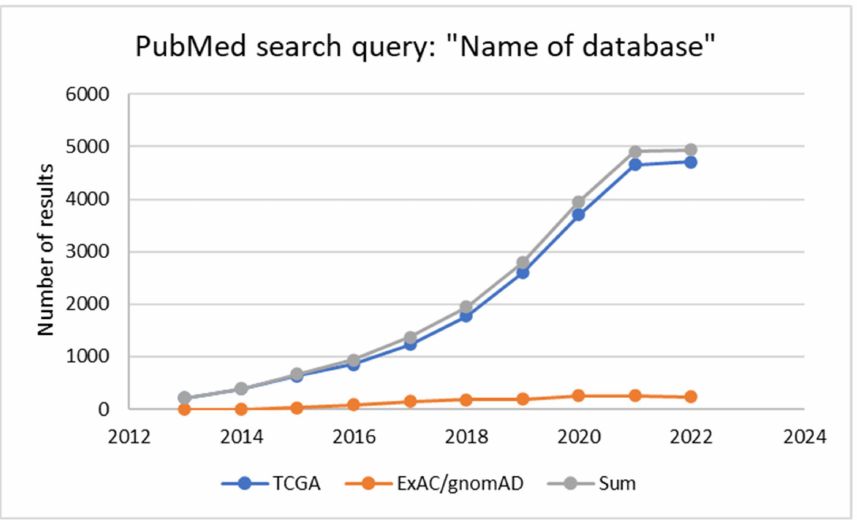
Figure 2. Number of results of the PubMed search query “Name of database” for two databases described in the